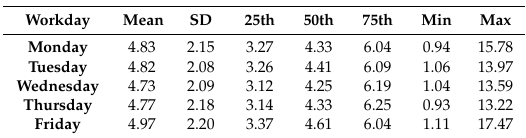
Table 7. Basic statistics of travel speed (m/s) for link 82.